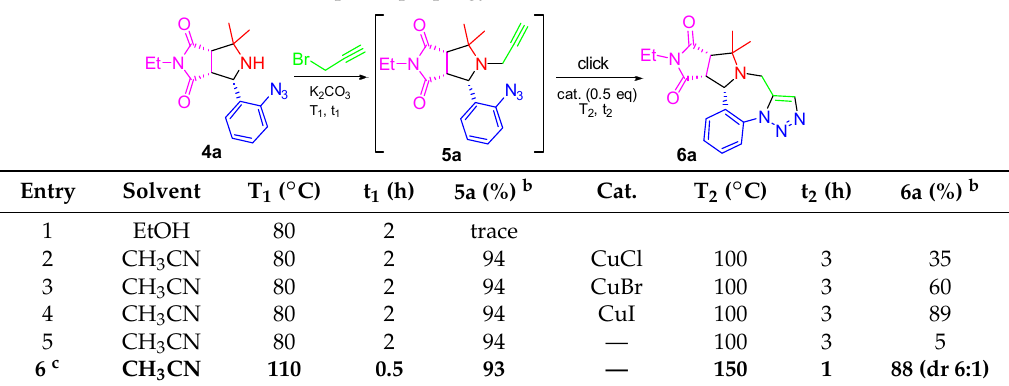
Table 2. One-pot N -propargylation and click reaction a .